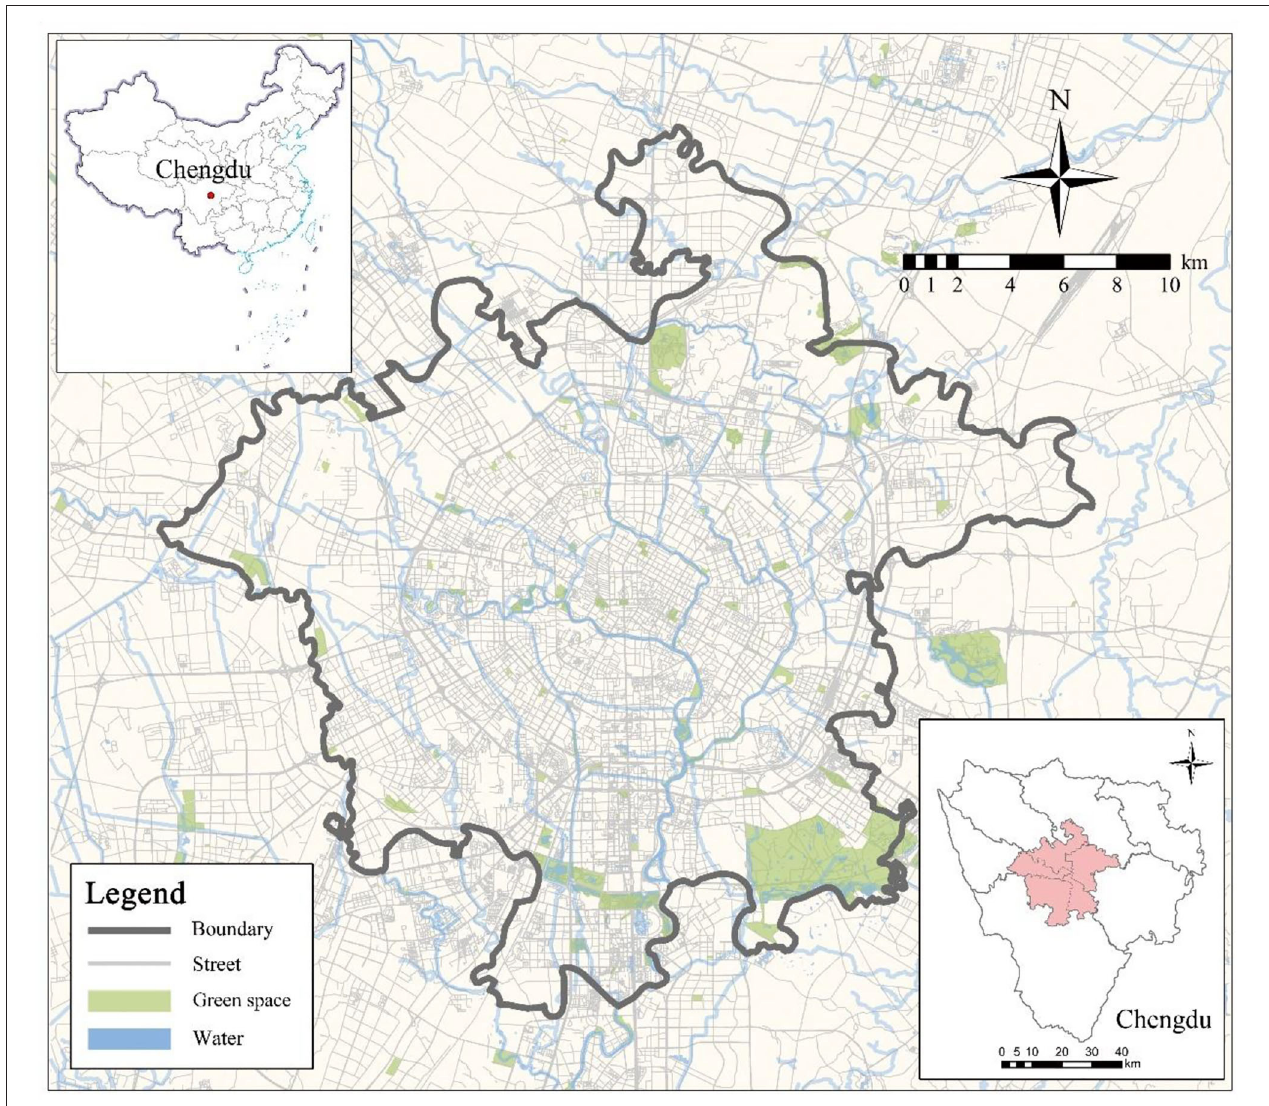
FIGURE 1 | The study area: central